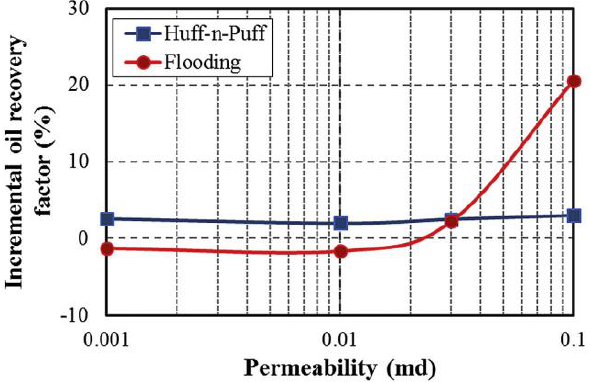
Figure 4. Comparison of incremental oil recovery factor between CO 2 flooding and CO 2 huff-n-puff, for the range of permeability from 0.001 to 0.1 md Reprint with permission [59], 2017, Elsevier.